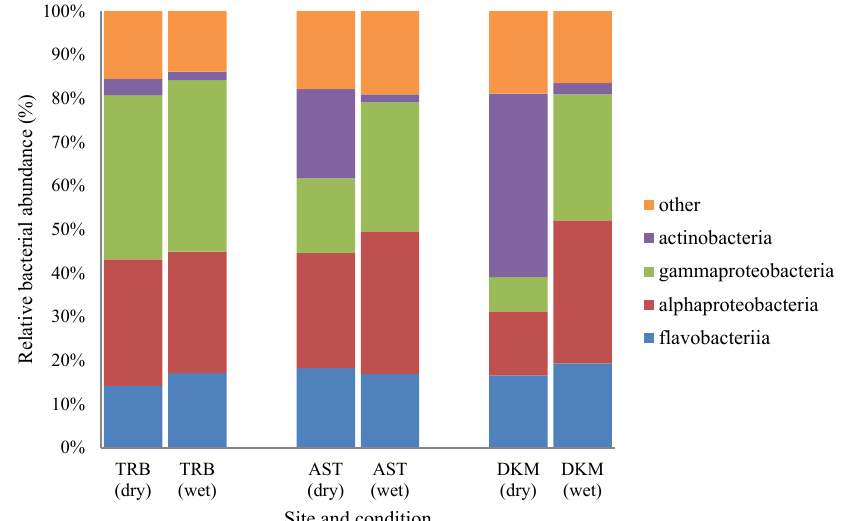
Fig. 2: Relative bacterial abundance (by class) of samples taken from Newtown Creek on dry (09/08/2016) and wet (09/15/2016) days from TRB, AST, and DKM sites